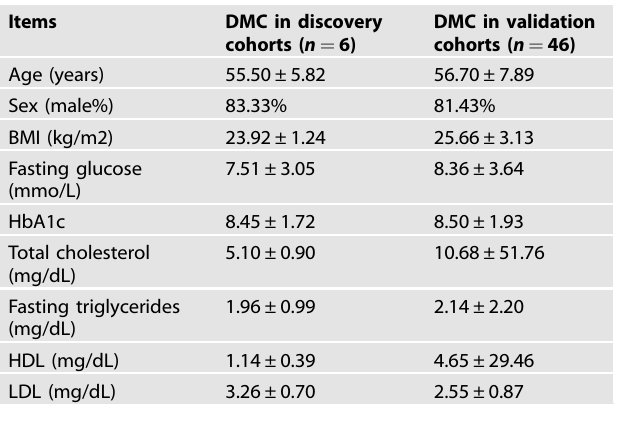
Table 1. Clinical characteristics of included patients of type 2 diabetes with macrovascular complication (DMC) in discovery cohorts ( n = 6) and in validation cohorts ( n = 46).